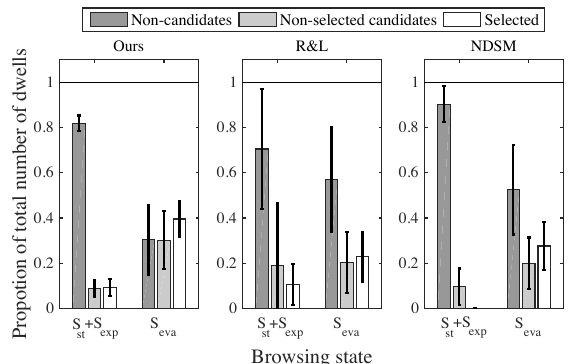
Figure 10 . The proportion of total dwells on selected items, non-selected candidates and the other items when the num- ber of candidates is 2. The whiskers represent standard devi- ation.